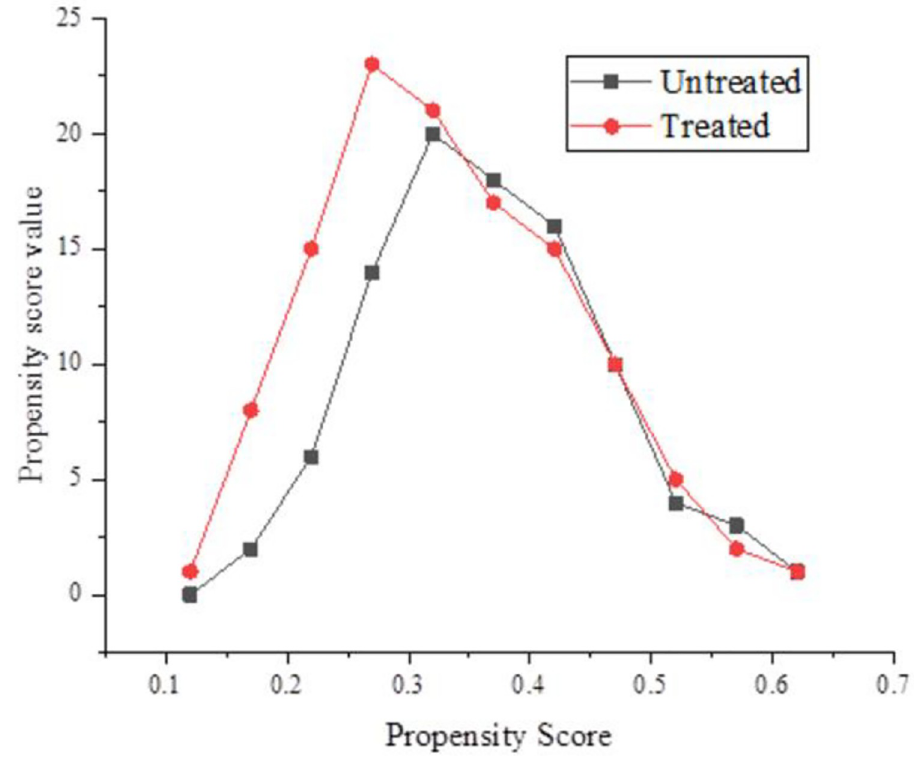
Fig 8. Range of propensity